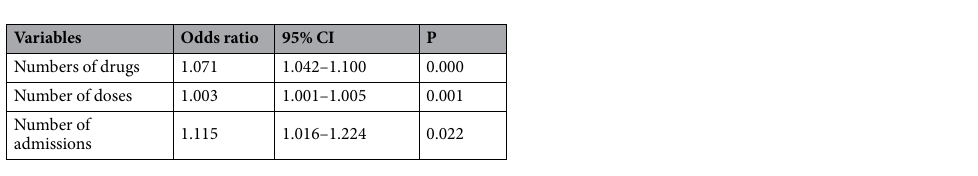
Table 6. Stepwise logistic regression results of the occurrence of ADEs.